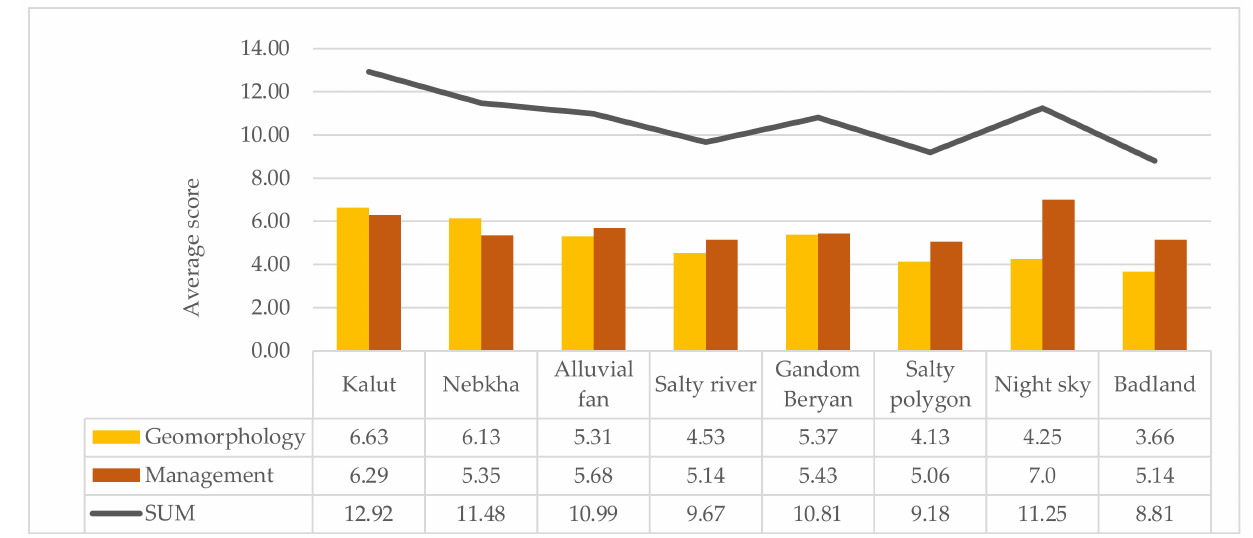
Figure 2. Final results of the evaluation of the studied sites using the Pereira